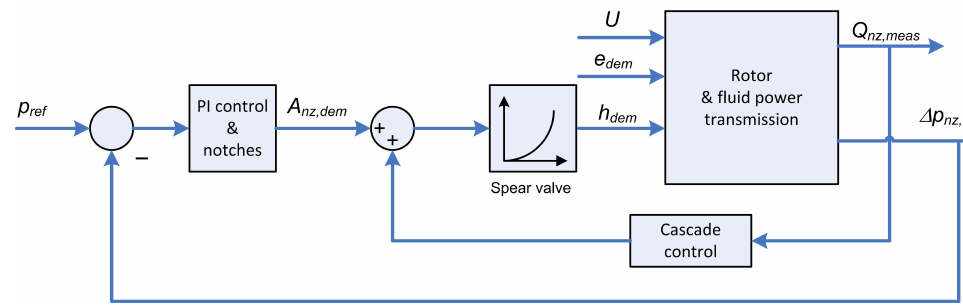
Figure 9. Pressure control schematic based on the spear valve position of the nozzle.